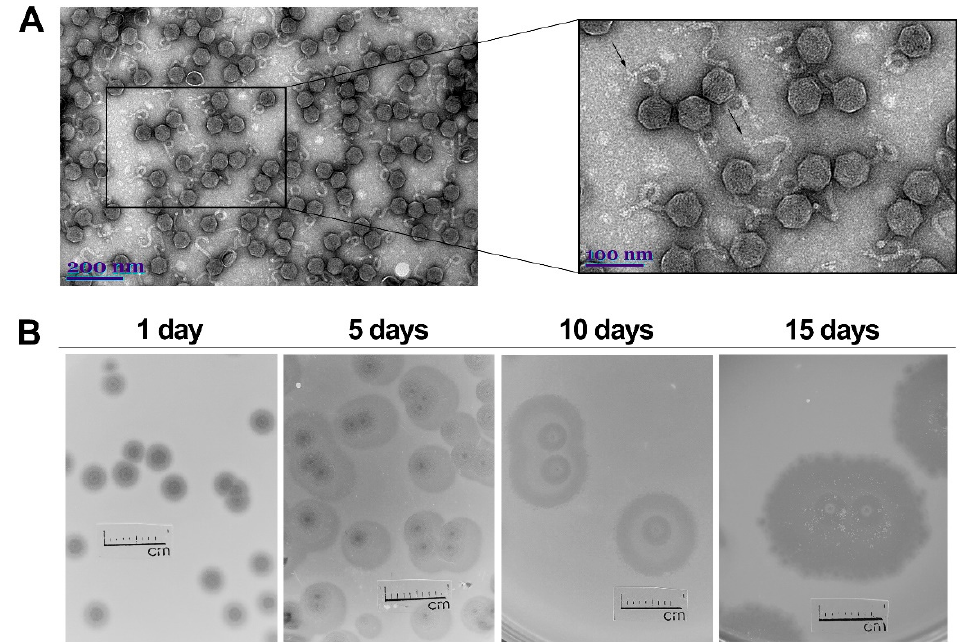
Figure 1. Electron micrographs of CsCl-purified MED16 particles ( A ) and morphology of plaques formed by phage MED16 on a lawn of Pantoea agglomerans strain BSL ( B ). ( A ) Black arrows indicate tail fibers; ( B ) plates were incubated at 22 °C, numbers above indicate days of incubation.